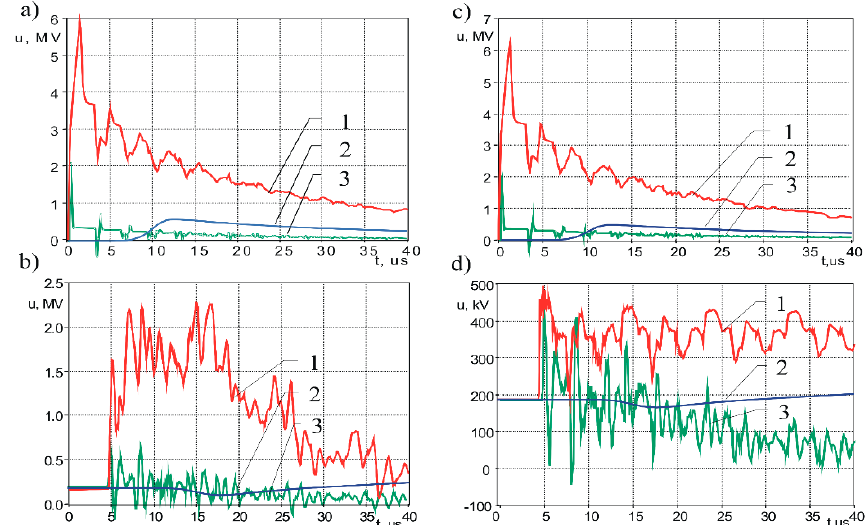
Figure 5. Overvoltages at the part of the electrical network with overhead transmission lines of 220 kV (Figure 2) simulated during the lightning stroke to the shielding wire (33.3 kA) in Point 1 of line: ( a , b ) Power substation without surge arresters, ( c , d ) power substation with surge arresters: ( a , c ) Overvoltages at the tower (Point 1), ( b , d ) overvoltages between phase conductor and earth (Point 2): 1-CIGRE model for the lightning current, (2,3) Heidler’s model ((2) first stroke, (3) successive strokes).